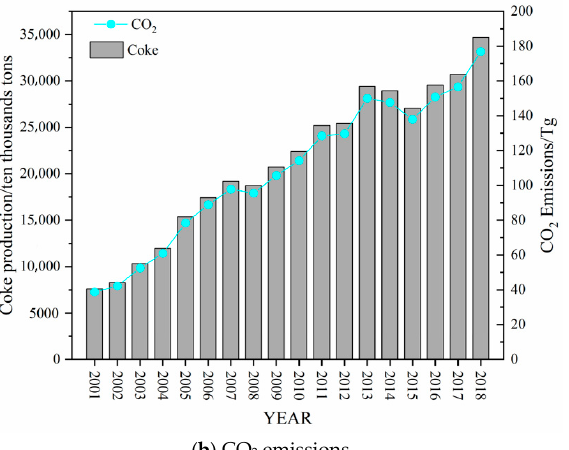
Figure 2. Annual production of coke and emissions of pollutants ( a ) (i.e., PM 10 , SO 2 , NO X , VOC S , CO, PM 2.5 , BC, and OC) and CO 2 ( b ) of China’s independent coking industry during 2001–2018.